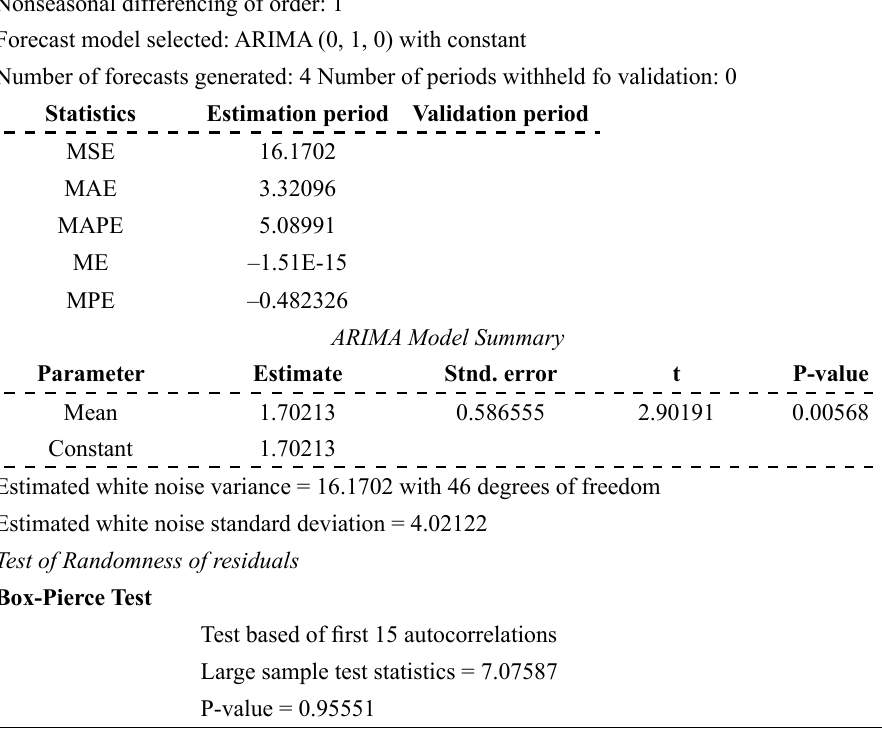
Table 4. ARIMA (0,1,0)